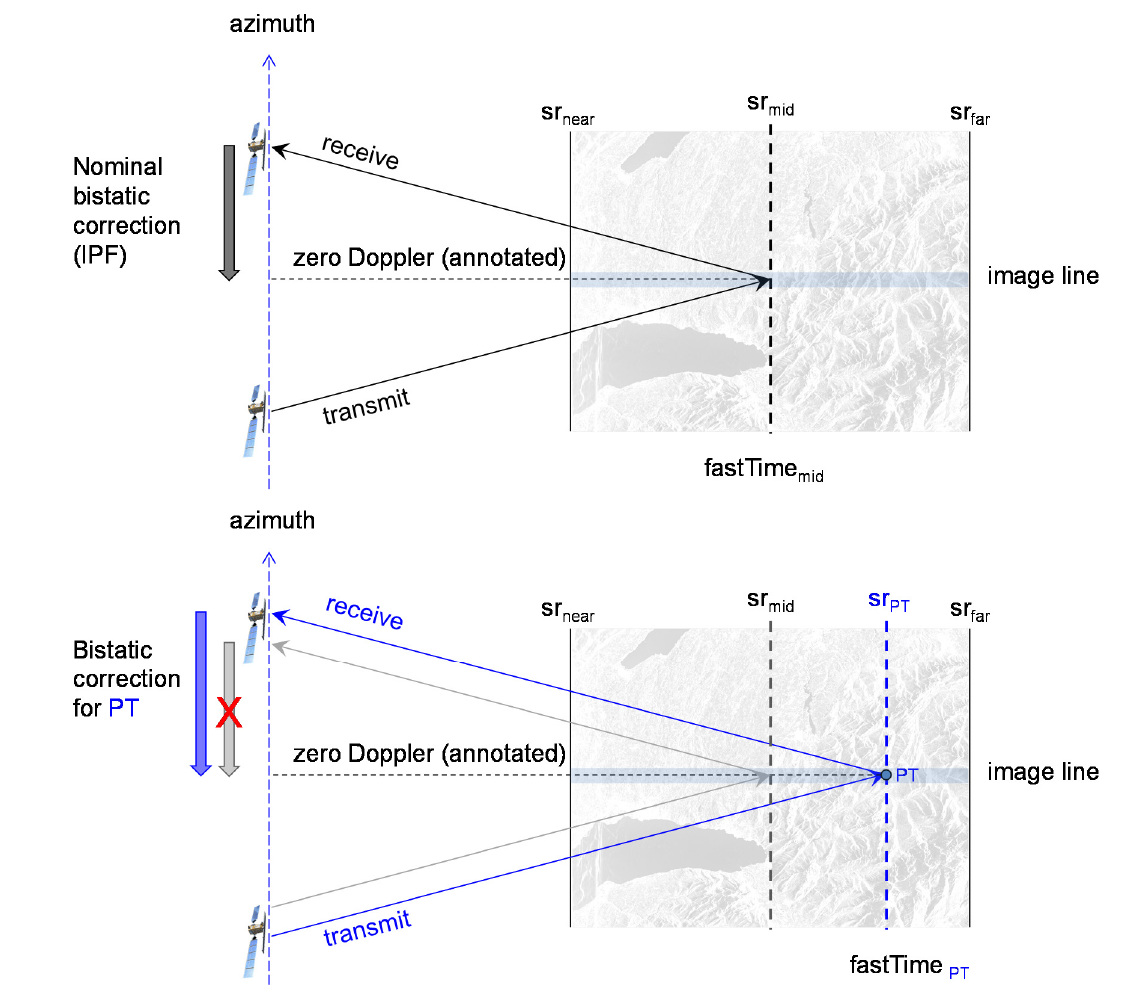
Figure 5. Calculation of the bistatic residual for a point target in an S1A StripMap product ( a ) nominal mid-range bistatic correction applied for a StripMap product by the S1 IPF as of v2.43; ( b ) bistatic correction needed for a point target PT at slant range sr PT